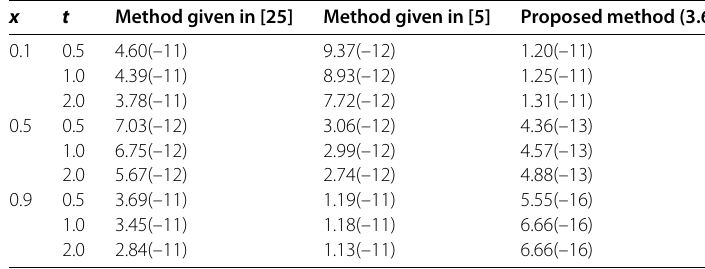
Table 9 Example 4: Case 1.3(c): Maximum absolute errors at δ =